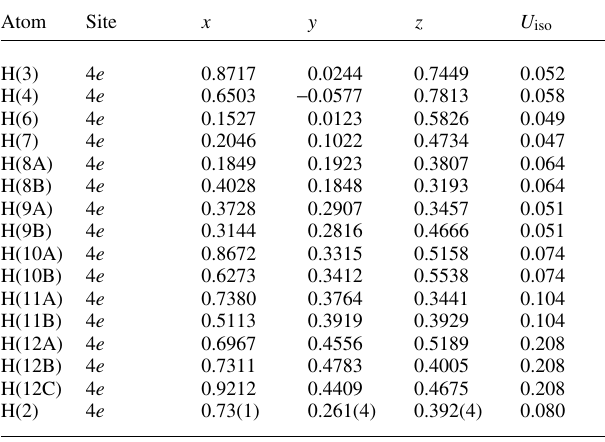
Table 2. Atomic coordinates and displacement parameters (in Å 2 )